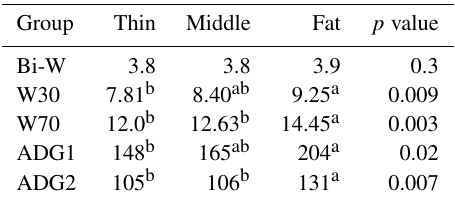
Table 4. Lamb growth parameters. Group Thin Middle Fat p value Bi-W ADG2 105 b 106 b 131 a 0.007